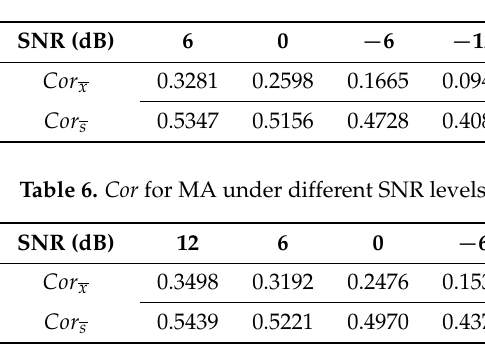
Table 5. Cor for EM under different SNR levels.